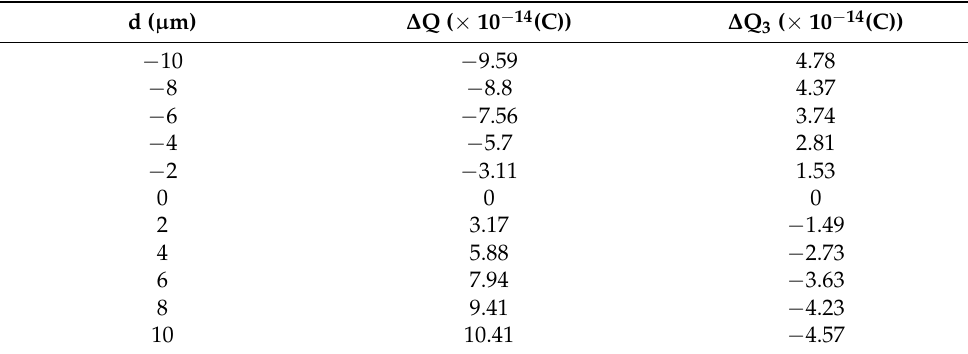
Figure 7. The variation of induced charge on electrodes versus the displacement of the movable electrodes. Table 2. Induced charge variations on electrodes.